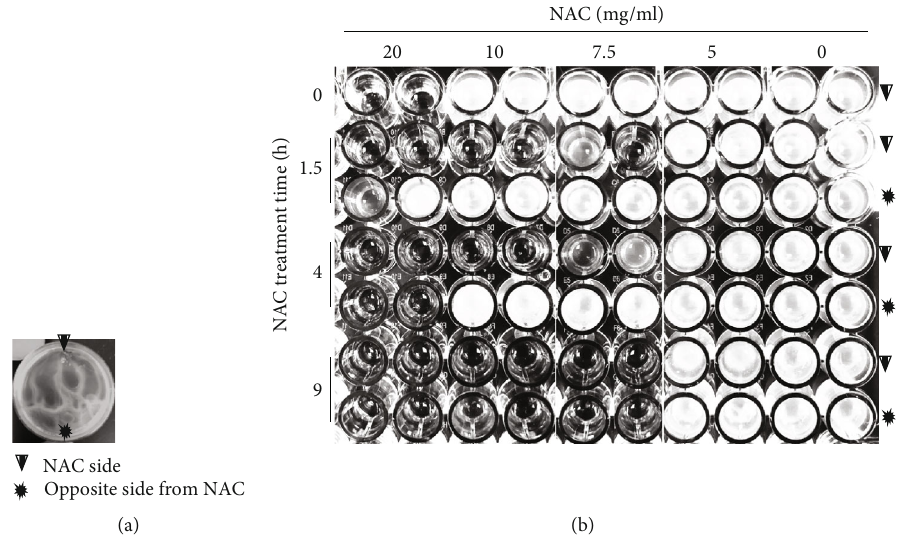
Figure 3: The e ff ect of NAC on the growth of bacteria contained in bio fi lm. We used the culture shown in Figure 2(c) to perform this experiment. (a) NAC was applied to the culture from one side of the culture dish marked with an arrowhead. The other side of the plate where NAC was not applied is marked by a star. (b) E ffi ciency of NAC in penetrating the bio fi lm and interfering with bacterial cell growth. After 0, 1.5h, 4 h, and 9 h NAC treatments, cells from the side where NAC was applied (arrowhead) and away from the site of application (star) were subcultured in fresh LB in a microtiter plate. 20 mg/ml NAC were able to penetrate the culture and interfere with cell growth within 1.5h, and no cell growth was detected after 4h treatment. 10 and 7.5 mg/ml NAC were able to penetrate the culture and completely inhibit further cell growth after 9 h post application. 5mg/ml NAC could not inhibit cell growth. Technical duplicates were used for cell viabilities after being treated with di ff erent concentrations of NAC.